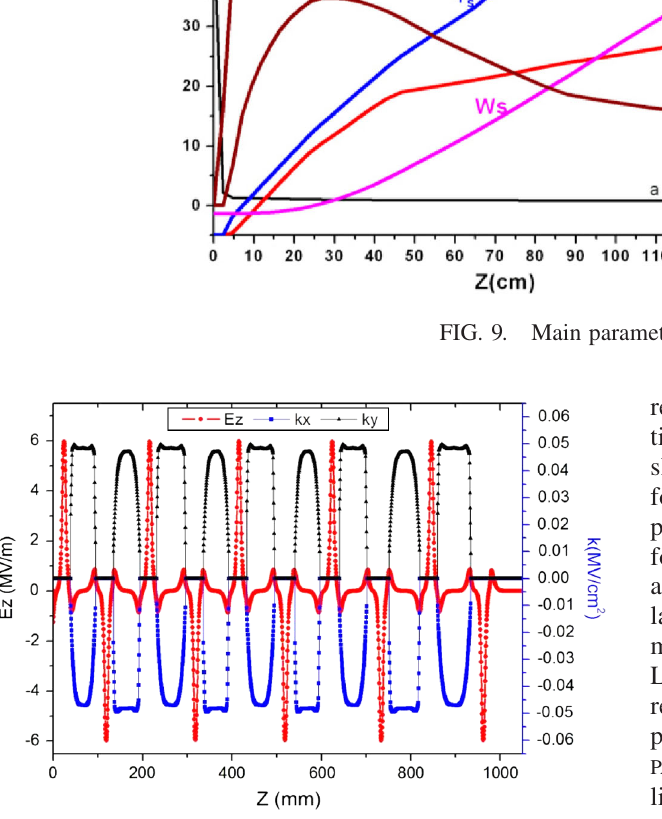
FIG. 10. The focusing and accelerating field distribution along the SFRFQ.